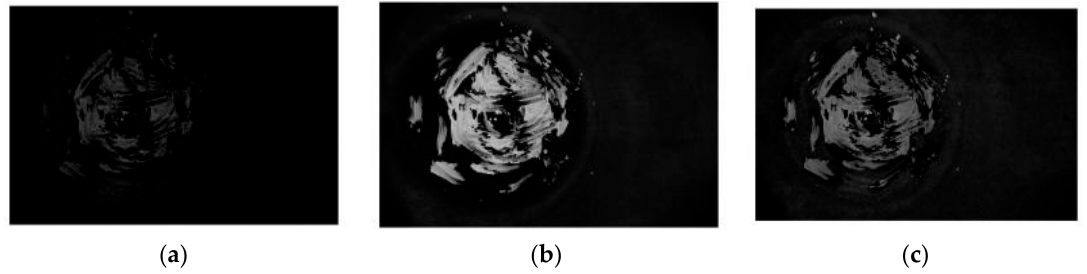
Figure 11. Digital image channels: ( a ) red channel; ( b ) green channel; ( c ) blue channel.